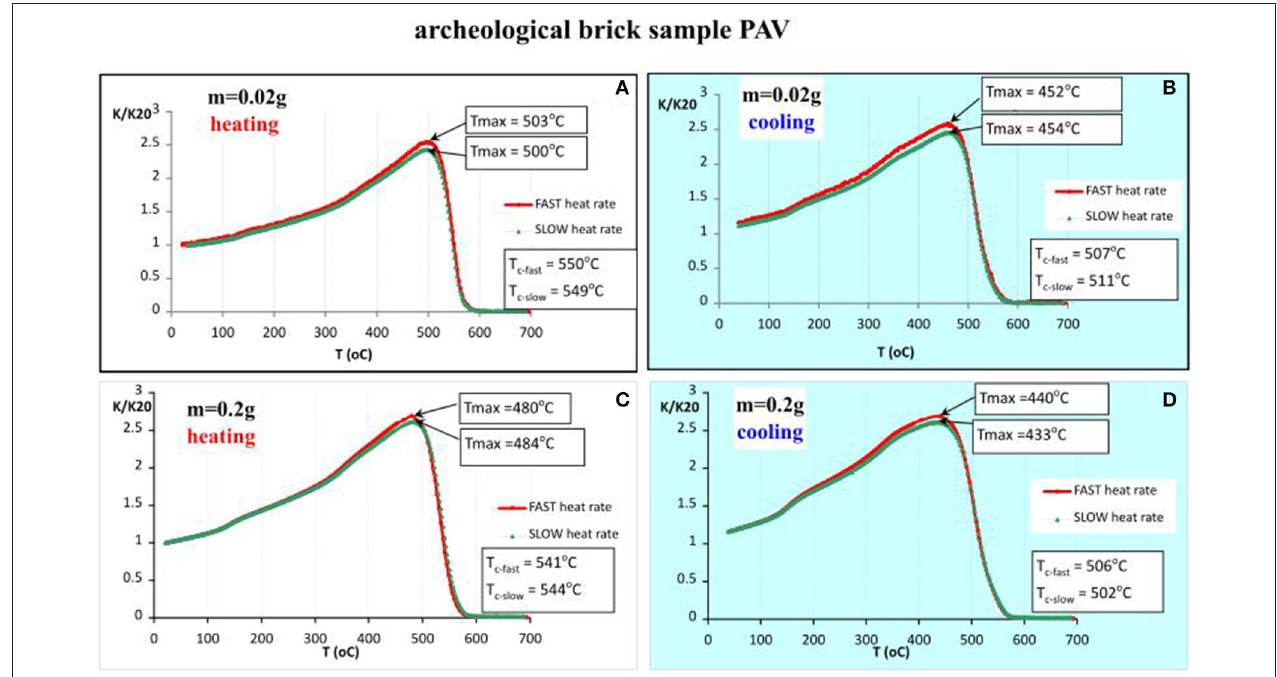
FIGURE 5 | Thermomagnetic analysis of magnetic susceptibility for archeological brick sample PAV, heating in air. (A) Heating curves using fast and slow heating rates for small sample size ( m = 0.02g); (B) cooling curves using fast and slow heating rates for small sample size; (C) heating curves using fast and slow heating rates for large sample size ( m = 0.2g); (D) cooling curves using fast and slow heating rates for large sample size.